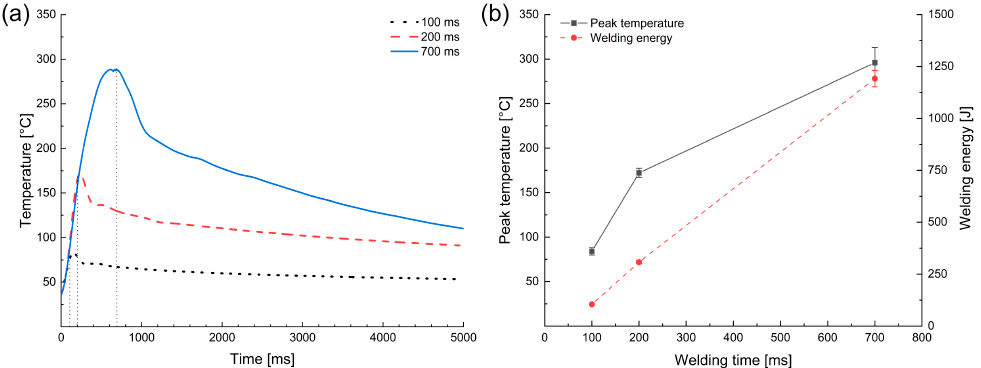
Figure 9. ( a ) Temperature–time profiles and ( b ) peak temperature and welding energy at different